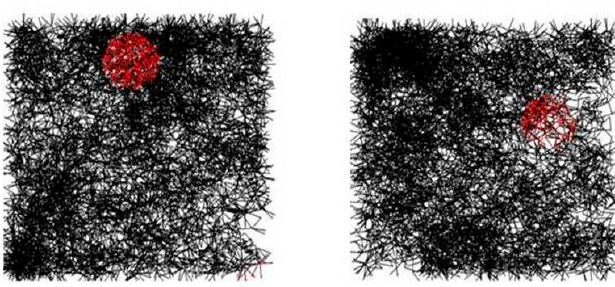
Figure 19. Place selective activation patterns of two individual place cells inside and outside the place